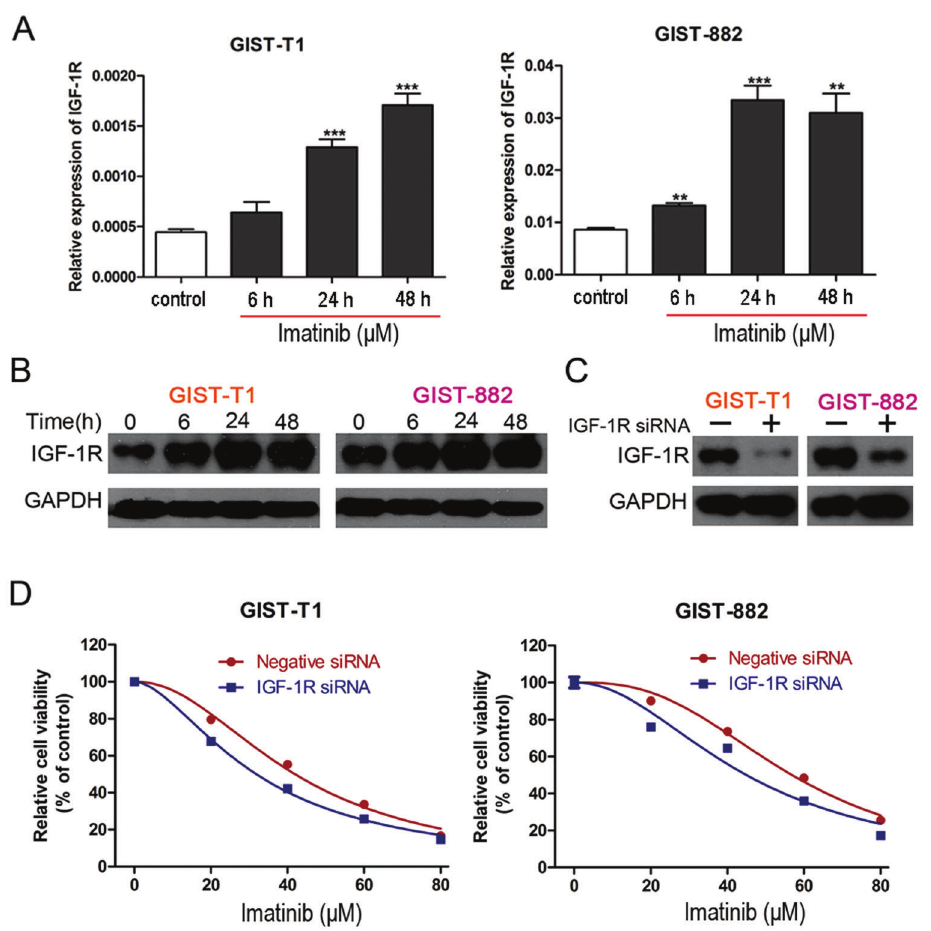
Figure 1. A , mRNA level of IGF-1R in GIST-T1 and GIST-882 cells treated with imatinib (GIST-T1, 41.97 m M; GIST-882, 56.90 m M) at different time-points by real time PCR. Data are reported as means ± SE. ** P o 0.01, *** P o 0.001 vs control (one-way analysis of variance followed by Tukey ’ s post hoc test). B , Protein level of IGF-1R in GIST-T1 and GIST-882 cells treated with imatinib at different time-points by western blot. C , The interfering ef fi ciency of IGF-1R con fi rmed by western blot. D , Cell viability of GIST-T1 and GIST- 882 cells with or without IGF-1R knockdown in the presence of different concentrations of